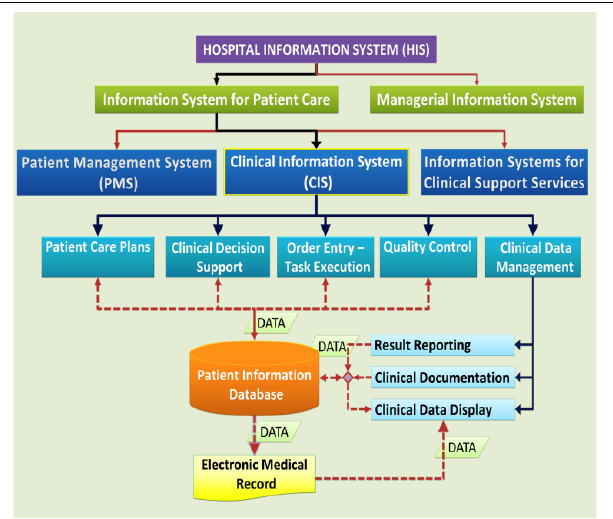
Figure 5. Information Systems Design